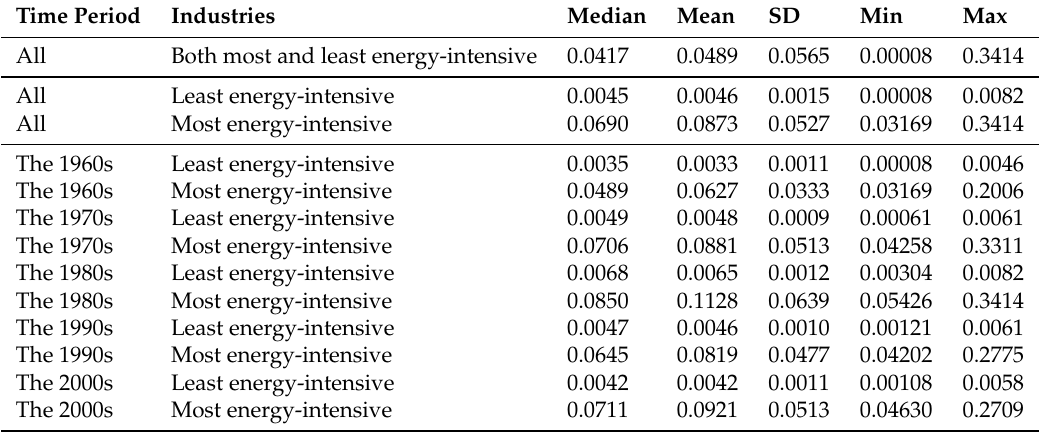
Table 1. Descriptive statistics of energy intensity by decade and by the intensity of energy